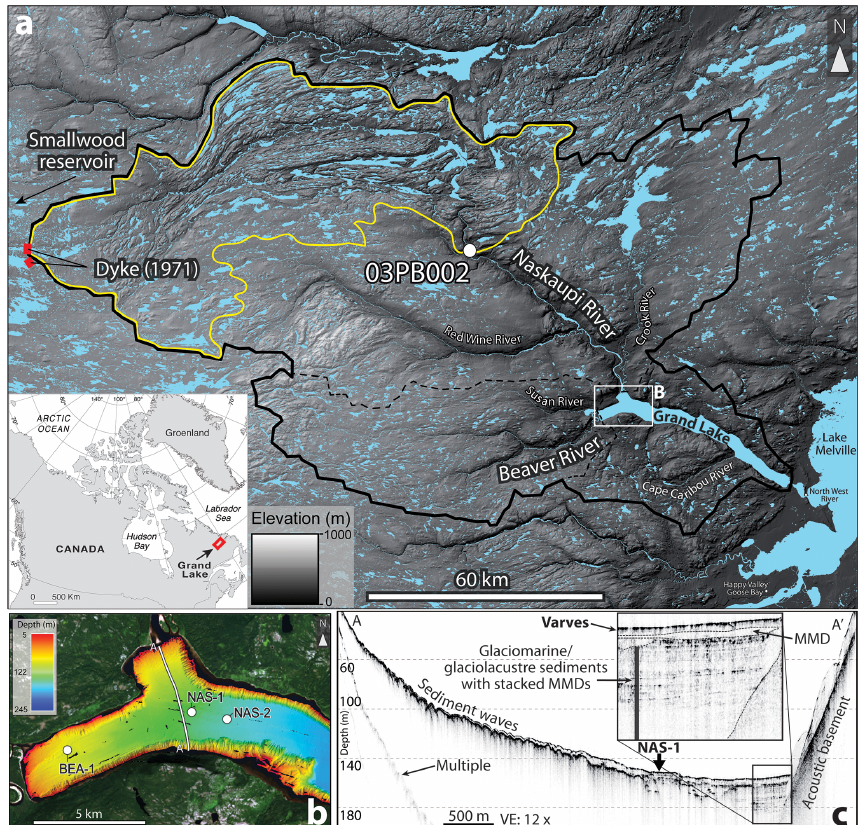
Figure 1. (a) Location of the Grand Lake watershed (black line) and its principal tributaries. The Naskaupi River hydrometric station (03PB002, white dot) covering an area of 4480km 2 (yellow line). The locations of the dykes constructed in 1971 to divert water from the Naskaupi River to the Smallwood Reservoir hydroelectric system are also shown by the red bars. (b) High-resolution swath bathymetry (1m resolution) of Grand Lake (Trottier et al., 2020) coupled with a Landsat image (USGS) and core site locations. The white line indicates the location of (c) a typical 3.5kHz sub-bottom profile of the Naskaupi River delta (A–A (cid:48) ) showing the approximate location of core NAS-1. MMD denotes a mass movement